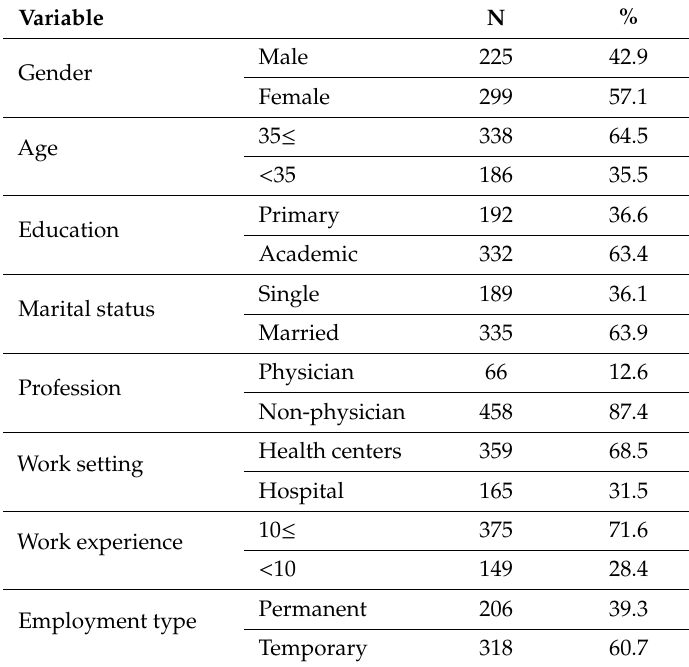
Table 2. Characteristics of the sample ( N = 524).